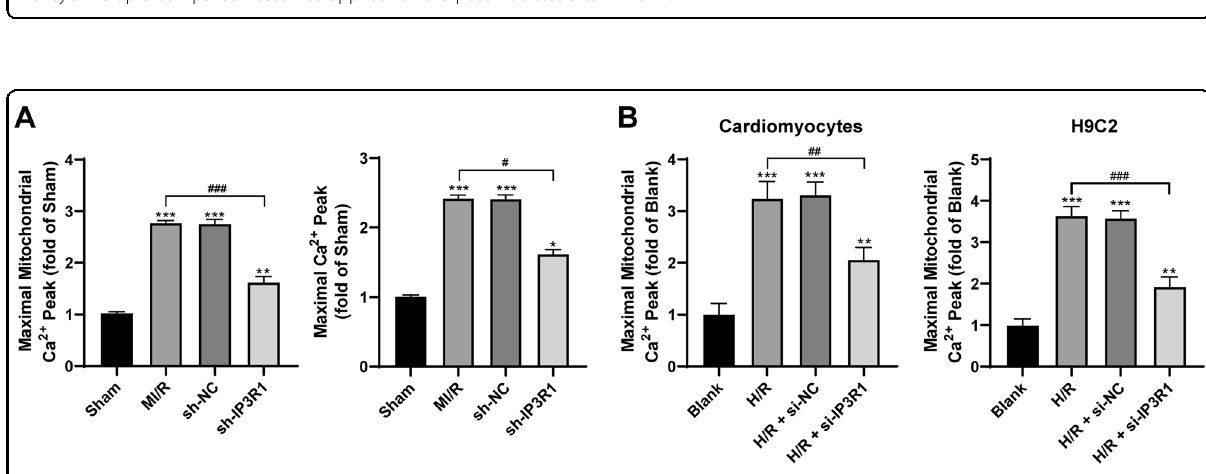
Fig. 3 Upregulation of IP3R1 leads to intracellular Ca 2 + overload in cardiomyocytes. A , B Fluo 4-AM and Rhod2 AM were used to observe the changes of Ca 2 + levels in cells and mitochondria; n = 6. Compared with the sham group, * p < 0.05, ** p < 0.01, *** p < 0.001; for pairwise comparison, # p < 0.05, ## p < 0.01, ### p < 0.001. Data were analyzed using one-way ANOVA and Tukey ’ s multiple comparison